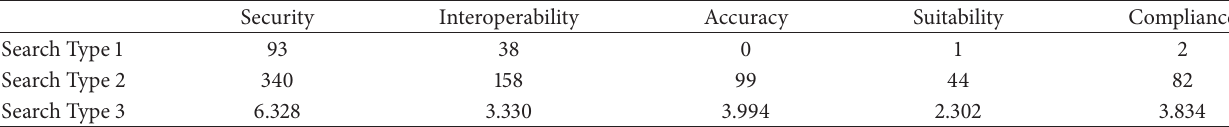
Table 4: Number of results of Search Types 1, 2, and 3, respectively, for Functionality.